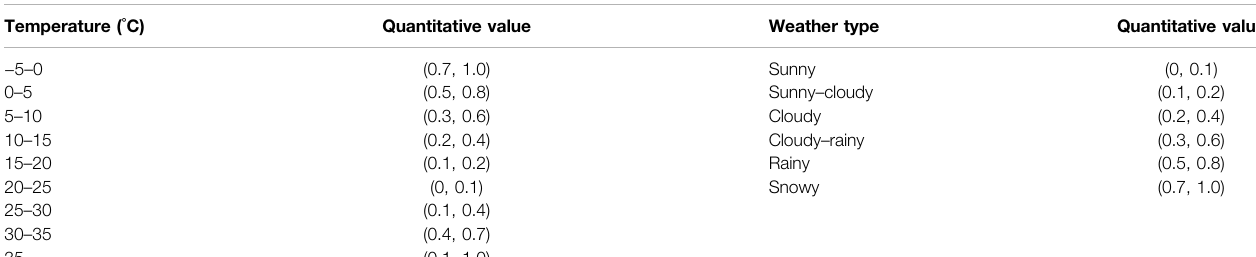
TABLE 2 | Quantitative value of meteorological